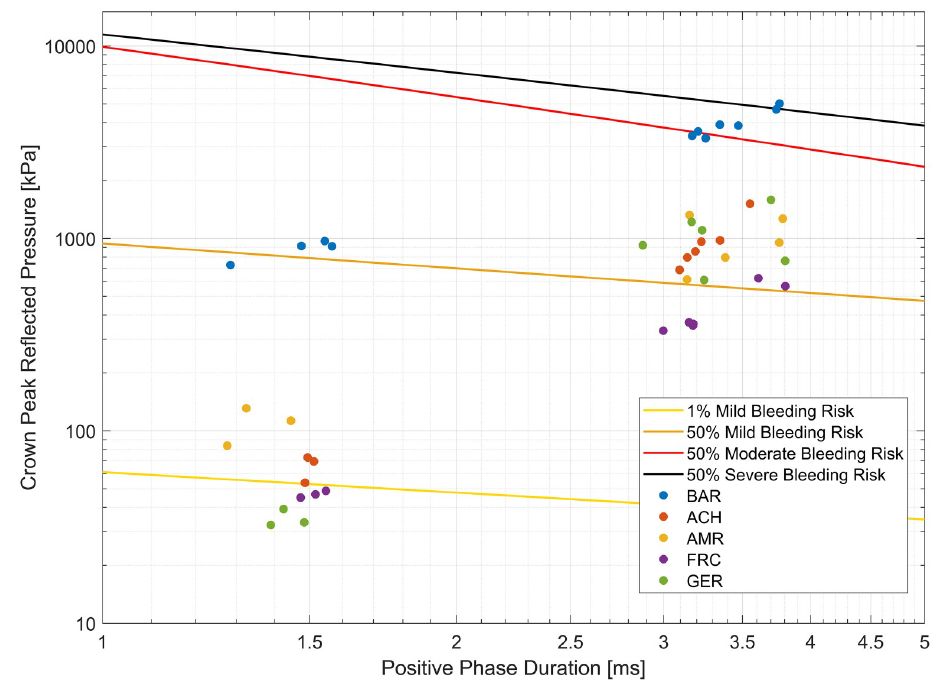
Fig 9. Helmets reduce the risk of meningeal bleeding. Tested blast conditions plotted on brain blast meningeal bleeding risk curves from Rafaels et al. [24]. Bare head testing conditions are roughly situated in the 50% mild, moderate, and severe meningeal bleed risk range, whereas the bleeding risk for helmeted tests is much lower (see Fig 10 for a more detailed example).